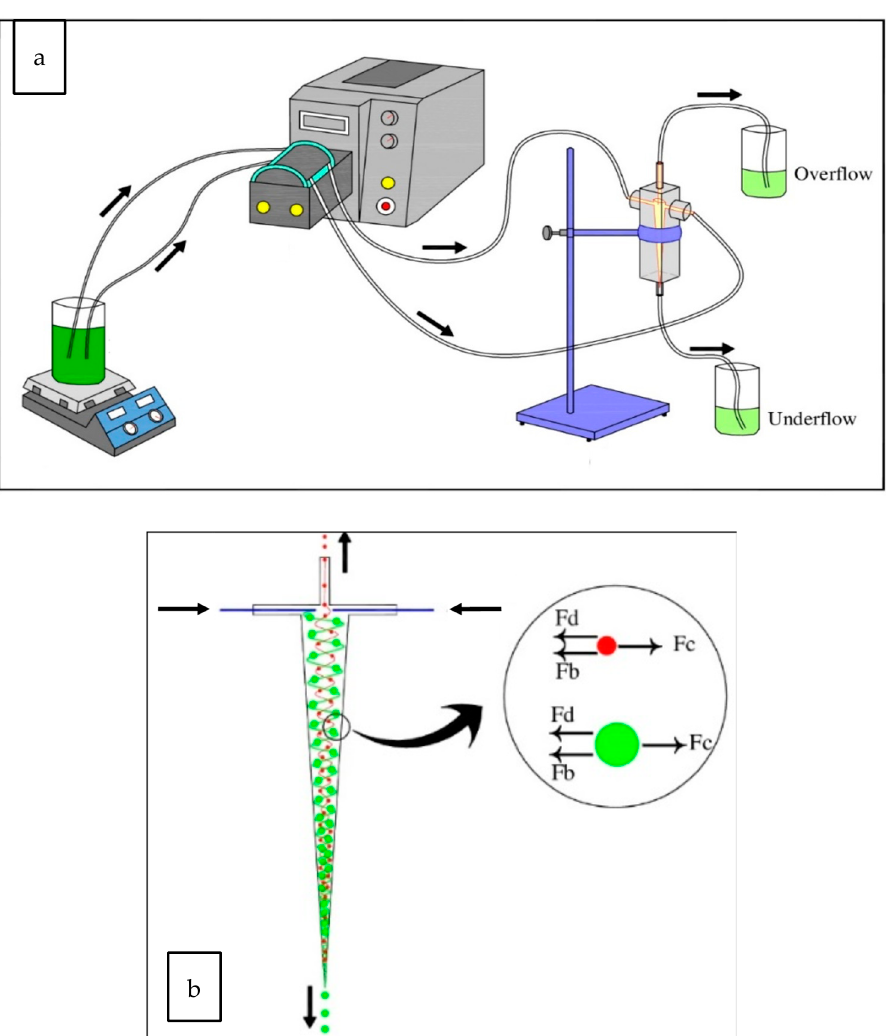
Figure 1. ( a ) Experimental set-up with the peristatic pump pushing a mixture of the two species, Microcystis and Scenedesmus , through the mini-hydrocyclone and into overflow and underflow beakers. ( b ) Hydrocyclone produced by pumping cells allows species to exit via the underflow and overflow ports. Pop-out shows the forces acting on cells within the hydrocyclone: the drag force (F d ), the buoyance force (F b ), and the centrifugal force (F c ).